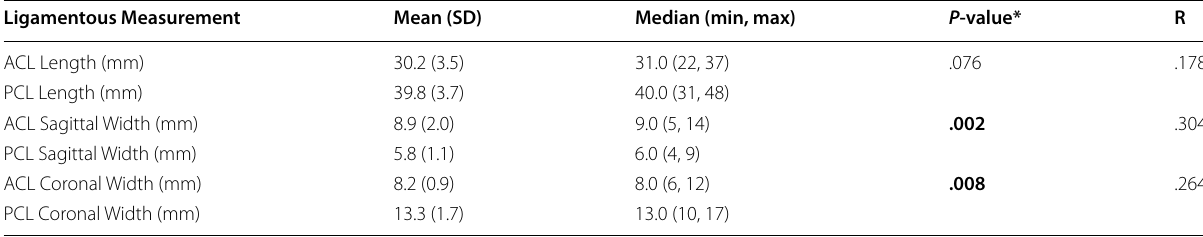
*Significance of PCL measurement as a predictor of ACL measurement